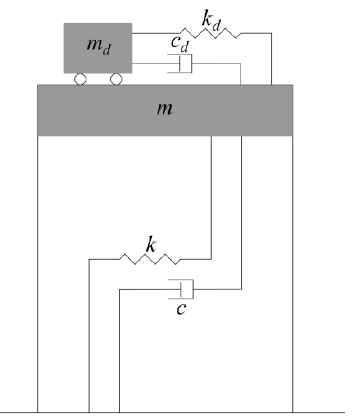
Figure 3. Schematic representation of the 2 DOF system.